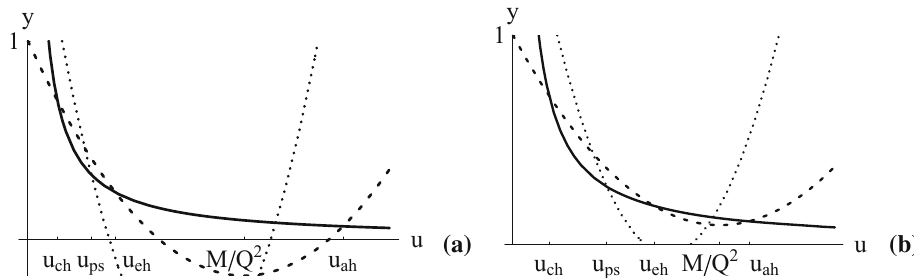
Fig. 1 Plots of y = 1 − 2 Mu + Q 2 u 2 ( dashed line ), y = σ u 3 w q + 1 of the dashed parabola and the continuous line provide the locations of ( continuous line ), and y = ( 2 − 6 Mu + 4 Q 2 u 2 )/ [ 3 (w q + 1 ) ] ( dotted the three horizons (11): ( u ch , u eh , u ah ). The point of intersection of the line ) versus u ≡ 1 / r for a Q 2 / M 2 ≤ 1, − 1 ≤ w q < − 1 / 3, and dotted parabola and the continuous line provides the only local maxi- σ < σ < − 1 / 3, and σ < σ < σ 2 / M 2 > 1, − 1 ≤ w mum value (18) of the potential V eff (16) for u ch < u < u eh , which is q 1 (7); b Q 2 1 (8). Here u ch = 1 / r ch , u eh = 1 / r eh , u ah = 1 / r ah . The points of intersection